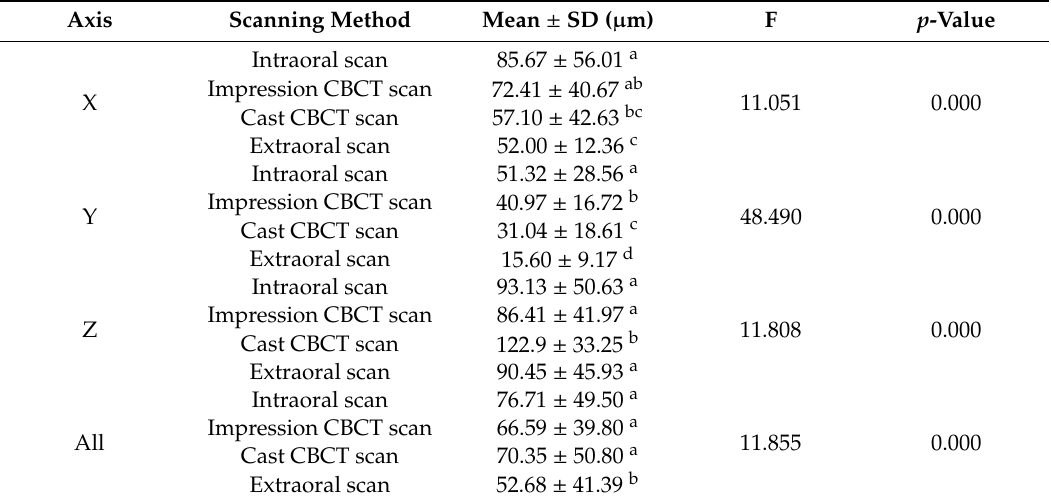
Table 2. Mean value of the deviation in each scanning method according to the axis.